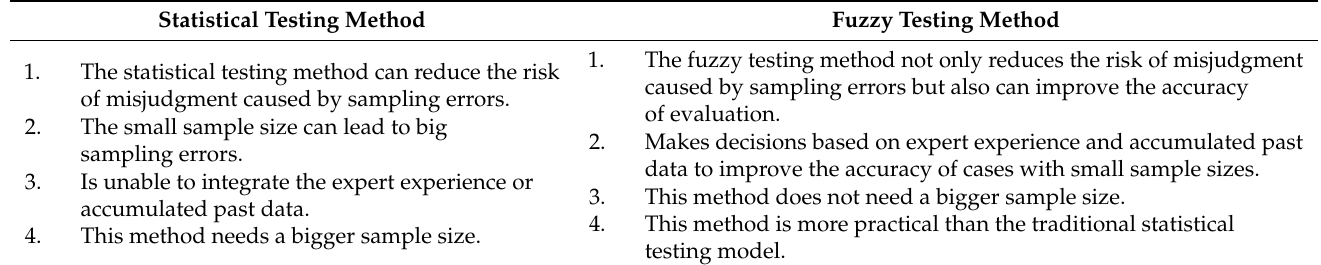
Table 1. The comparison of the statistical testing method and fuzzy testing